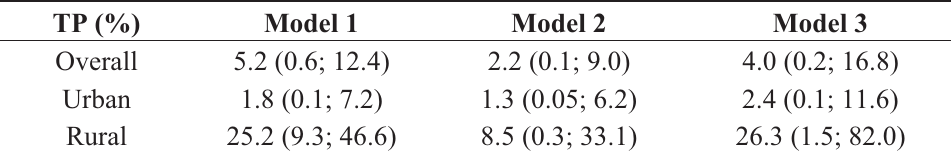
Table 3. Estimates of the True Prevalence (TP) (overall, urban and rural cats) and their 95% Credibility Intervals (CrI) that were obtained using a Bayesian approach, considering different models of the uncertainty for MAT-based sensitivity (Se) and specificity (Sp)